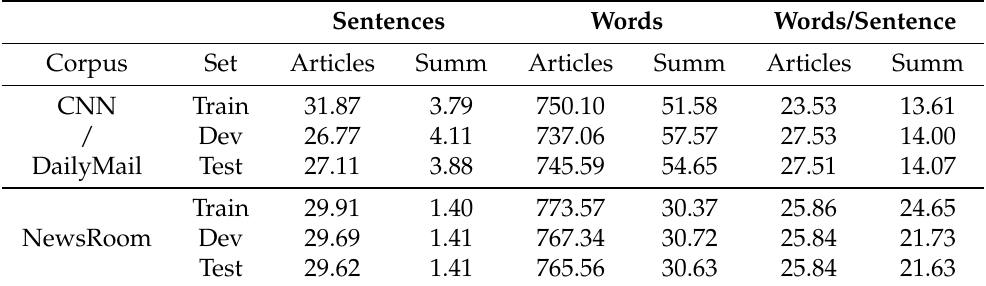
Table 1. Average number of sentences and words, including words per sentence, for both